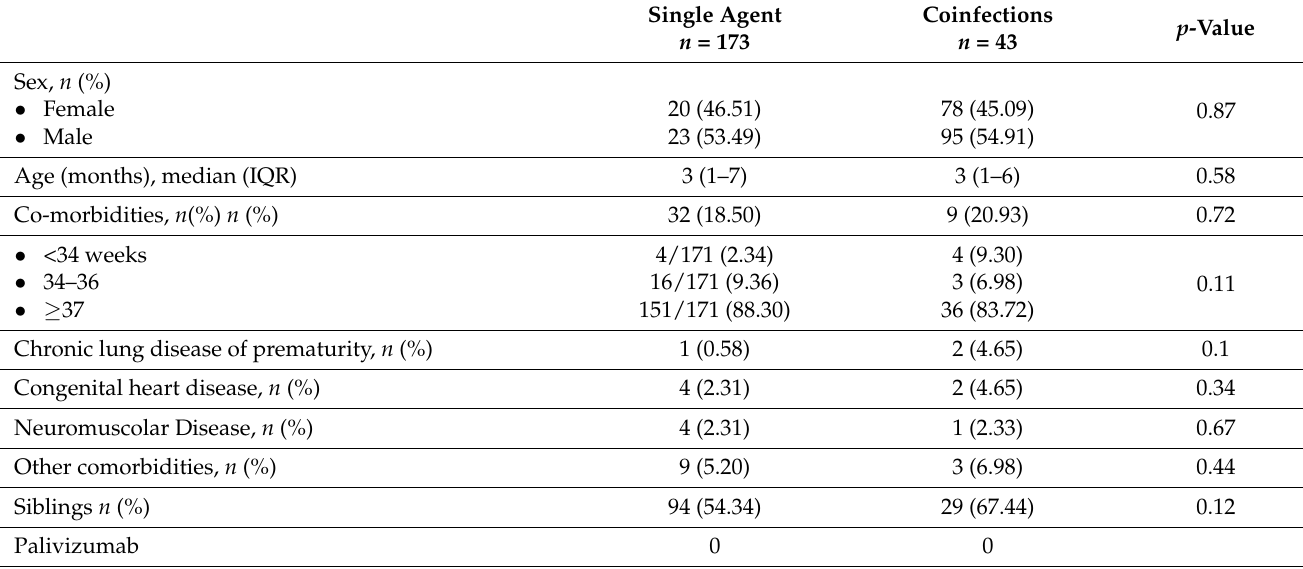
Table 4. Disease severity according to bronchiolitis sustained by a single virus or a co-infection. CPAP, continuous positive airway pressure; HFNC, high-flow nasal cannulae; PICU, pediatric intensive care